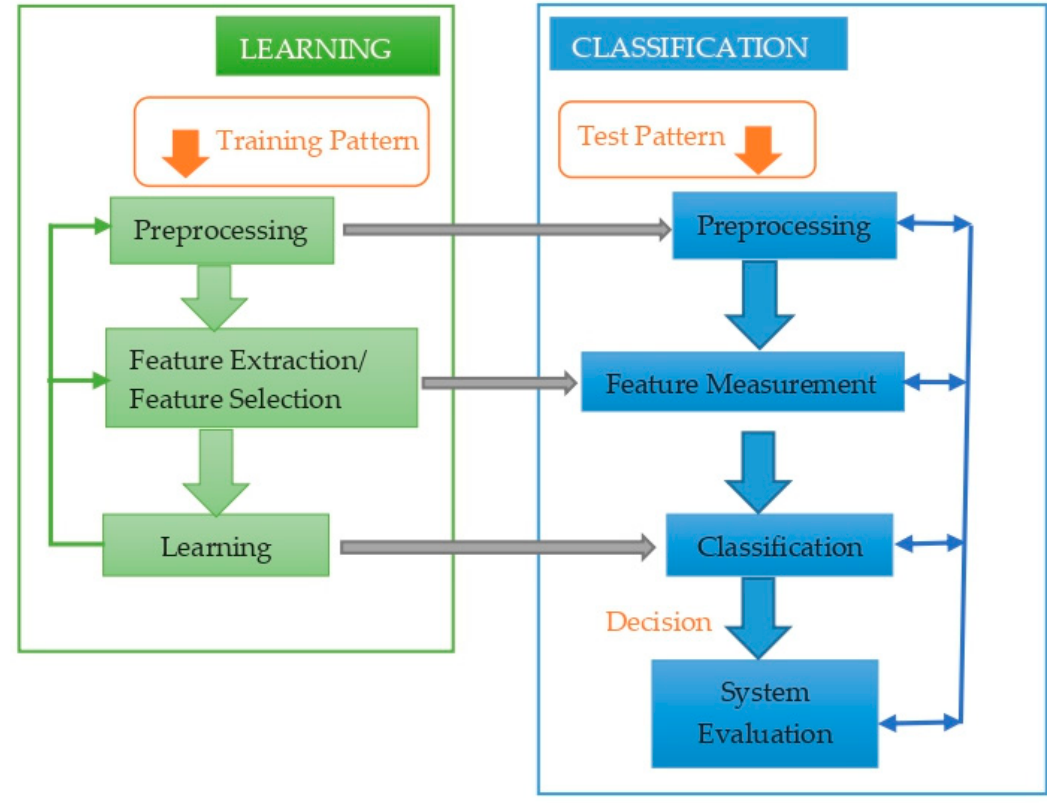
Figure 2. Schematic of pattern recognition.